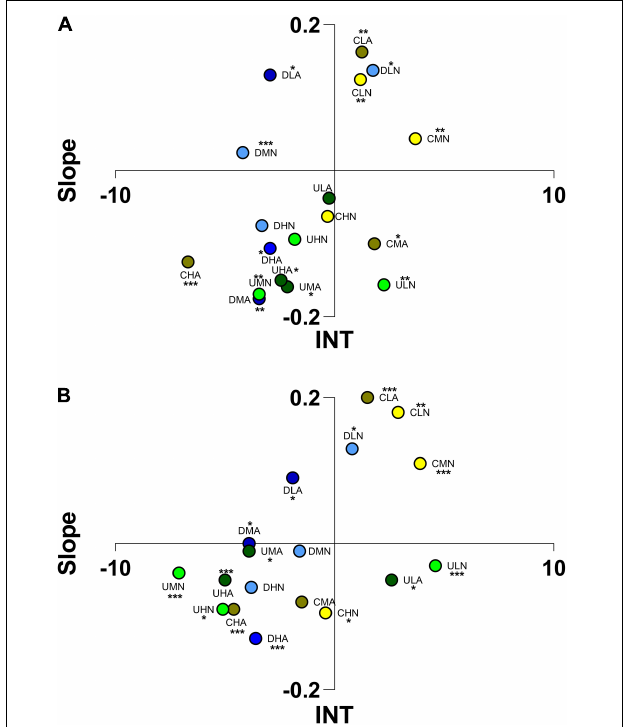
FIGURE 8 | Ordination into 1 of 4 sectors of Hippolyte inermis juveniles according to the scores reached for “Slope” and “INT” (integral time) in static arenas (A) and flow-through flumes (B) . The letters indicate the algae considered (C, Cocconeis scutellum var. parva ; D, Diploneis sp.; U, Ulva prolifera ), the concentration of VOCs (L, low; M, medium; H, high), and the culture and test conditions (N, normal conditions; A, acidified conditions). Asterisks indicate the significance of individuals’ position in the